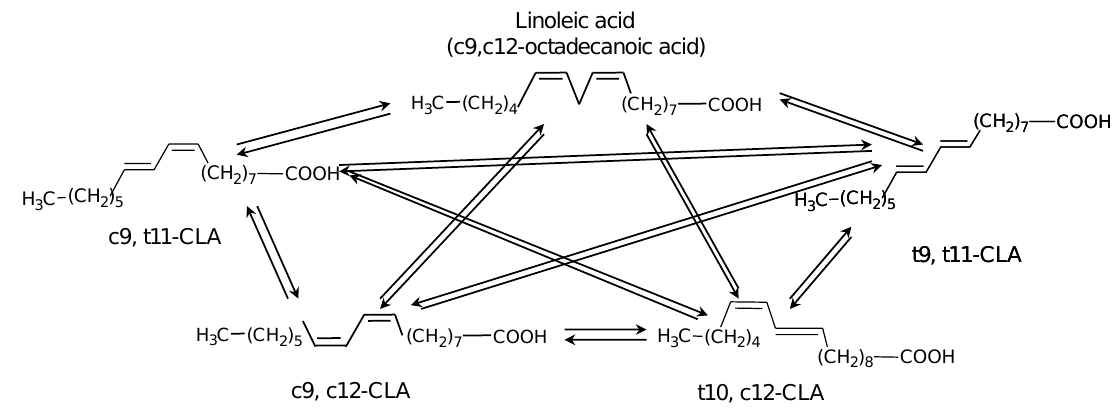
Figure 1. Main isomers of linoleic acid (c9, c12-octadecanoic acid) 36